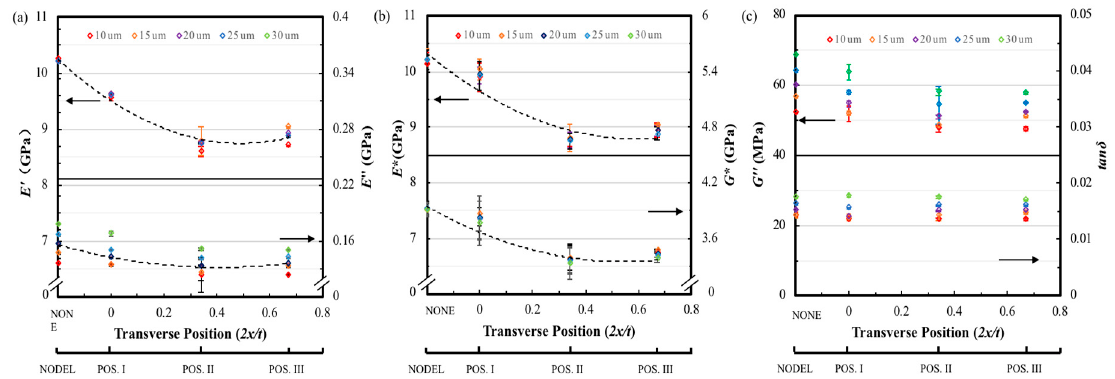
Figure 13. The dynamic mechanical properties of FFRP with different transverse delamination position tested at 25 °C, frequencies of 10 Hz, amplitude of 10, 15, 20, 25, and 30 µm. Variation of ( a ) E’ and E’ , ( b ) E* and G* and ( c ) tan δ with transverse delamination position.